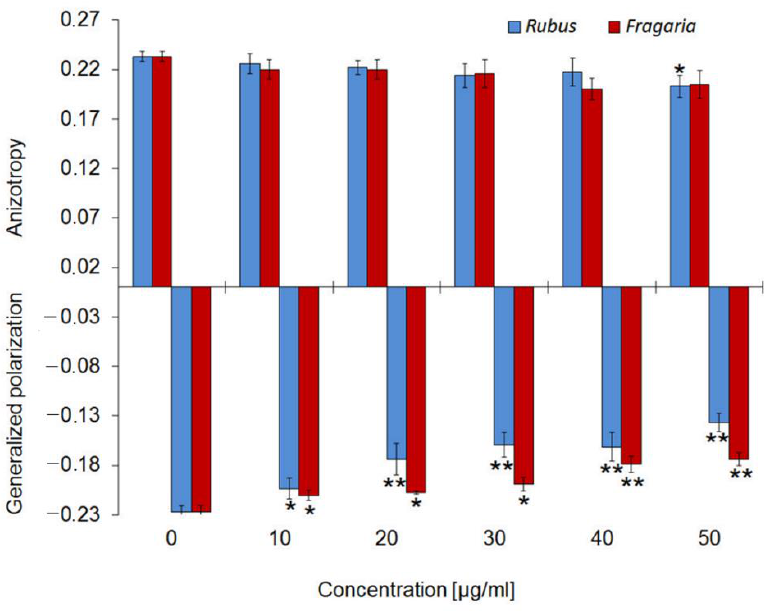
Figure 5. Values of generalized polarization (GP) of Laurdan probe and anisotropy (A) of DPH probe for erythrocyte membranes modified by Fragaria and Rubus leaf extracts and for unmodified cells. Statistically significant difference between results of control and extracts modified samples are denoted: *α = 0.05 and **α = 0.01, respectively.